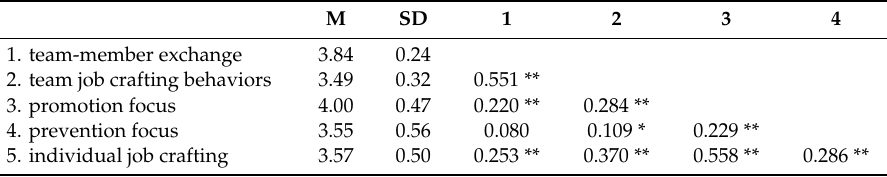
Table 8. The mean, SD, and Pearson’s correlation coe ffi cients for study